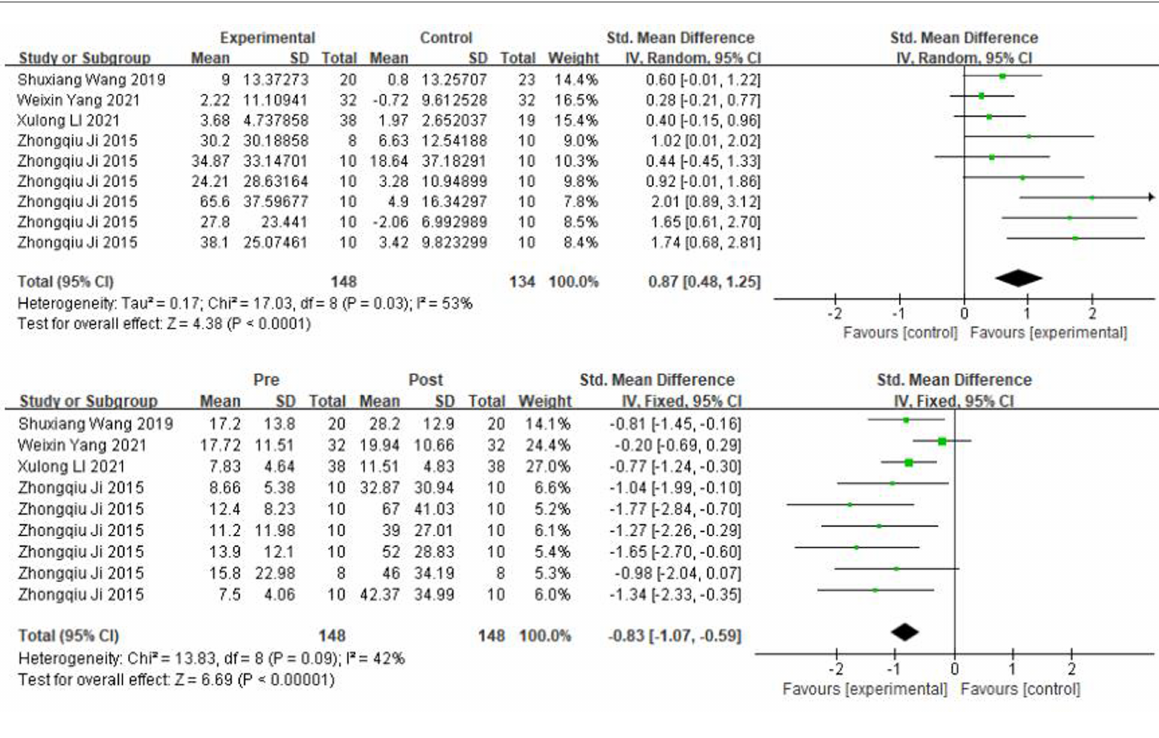
FIGURE 8 A meta-analysis of the results of closed-eye single-leg test was conducted for comparisons between the control and experimental groups and for comparisons between the experimental groups pre- and post-intervention.